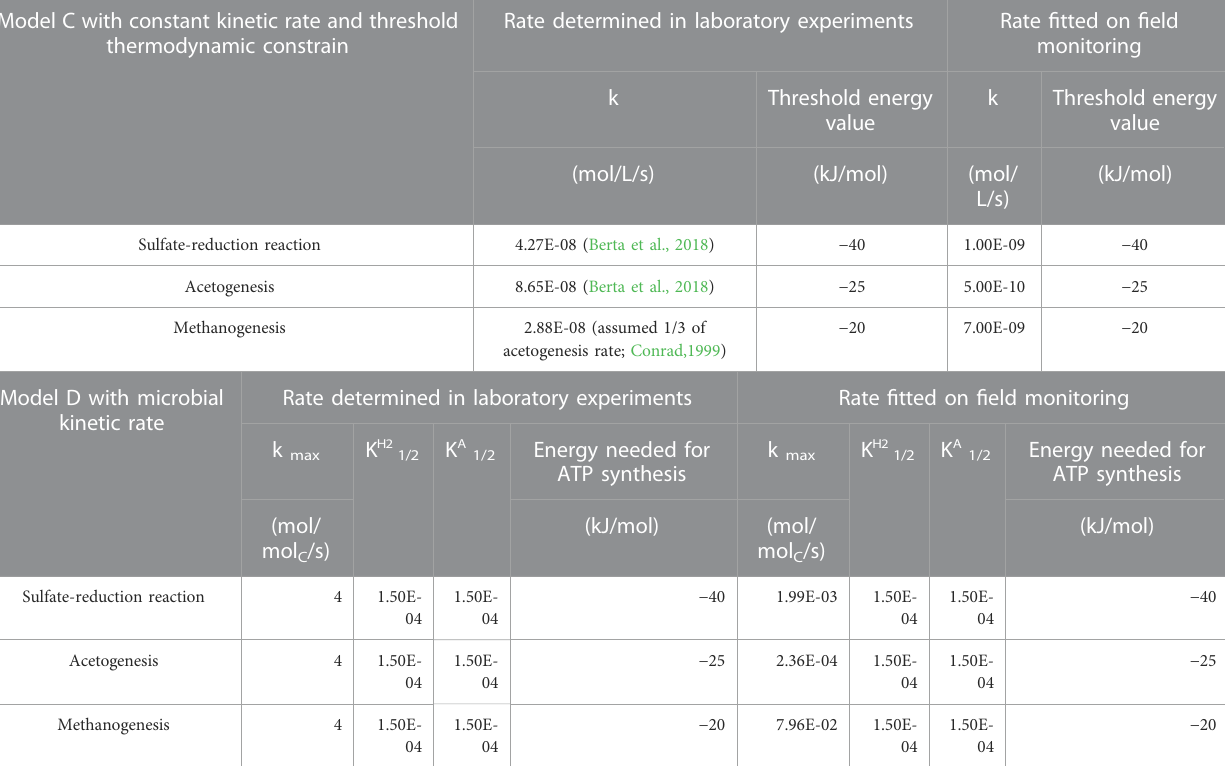
TABLE3Kineticratesusedforsulfate-reductionreaction,acetogenesisandmethanogenesisinthedifferentPHREEQCsimulations.InModelD,aconstantbacteria concentration of 10 4 cells/mL was considered, corresponding to 10 − 7 mol C /L assuming 1 cell contains 10 − 14 mol of Carbon. Model C with constant kinetic rate and threshold thermodynamic constrain